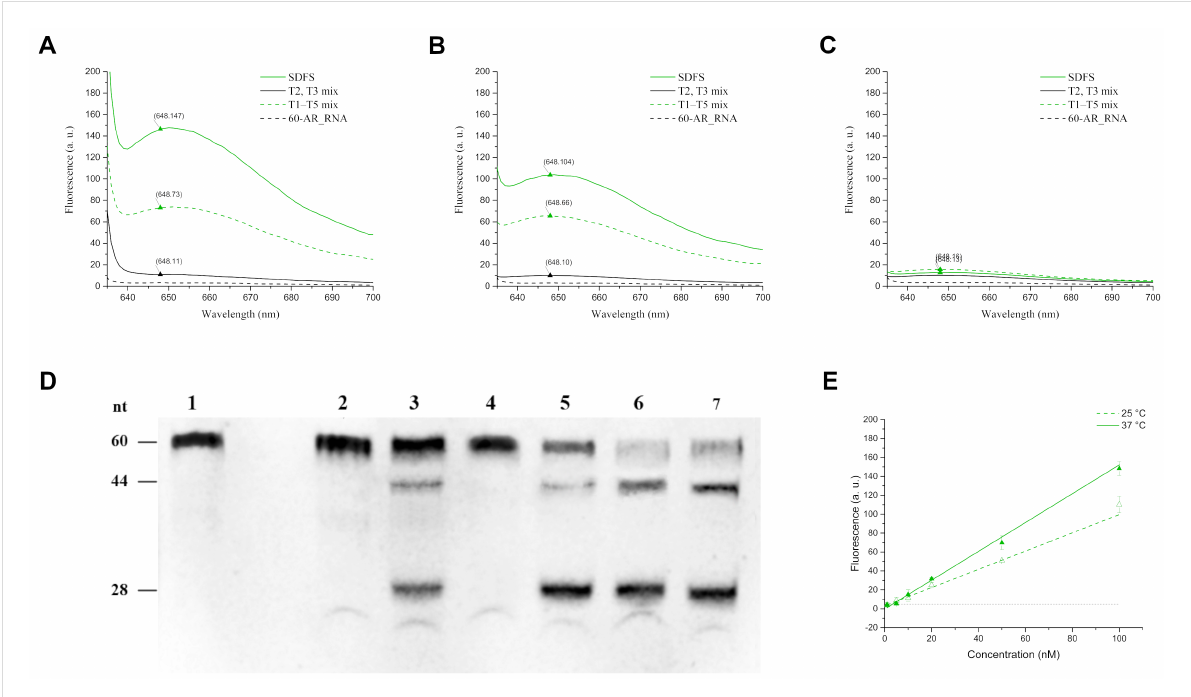
Figure 2: The SDFS functional activity. A–C) Emission spectra of the assembled SDFS (green line), T1–T5 chains mix without annealing (green dotted line), MGA sample containing free T2 and T3 chains (black dotted line), and a control sample with 60-AR_RNA (black line) after 24 h of incuba- tion at 37 °C, 25 °C, and 4 °C for A), B), and C), respectively. D) Denaturing PAGE assessment of cleavage of samples containing 60-FAM-AR_RNA and different agents after 6 h of incubation; lanes 1 and 2: 60-FAM-AR_RNA incubated for 0 and 6 hours, respectively; lane 3: 60-FAM-AR_RNA and individual strands T1 and T4; lane 4: 60-FAM-AR_RNA, T2 and T3; lane 5: 60-FAM-AR_RNA with mix of T1–T5 strands; lanes 6 and 7: 60-FAM- AR_RNA with assembled SDFS in the absence or presence of malachite green, respectively. E) Approximated limit of detection for SDFS at 37 °C (green line) and 25 °C (green dotted line). Each dot is an average of triplicate values of fluorescence with standard deviations for samples with differ- ent concentrations of 60-AR_RNA. A black dashed line indicates the threshold fluorescence value of the buffer with malachite green dye and